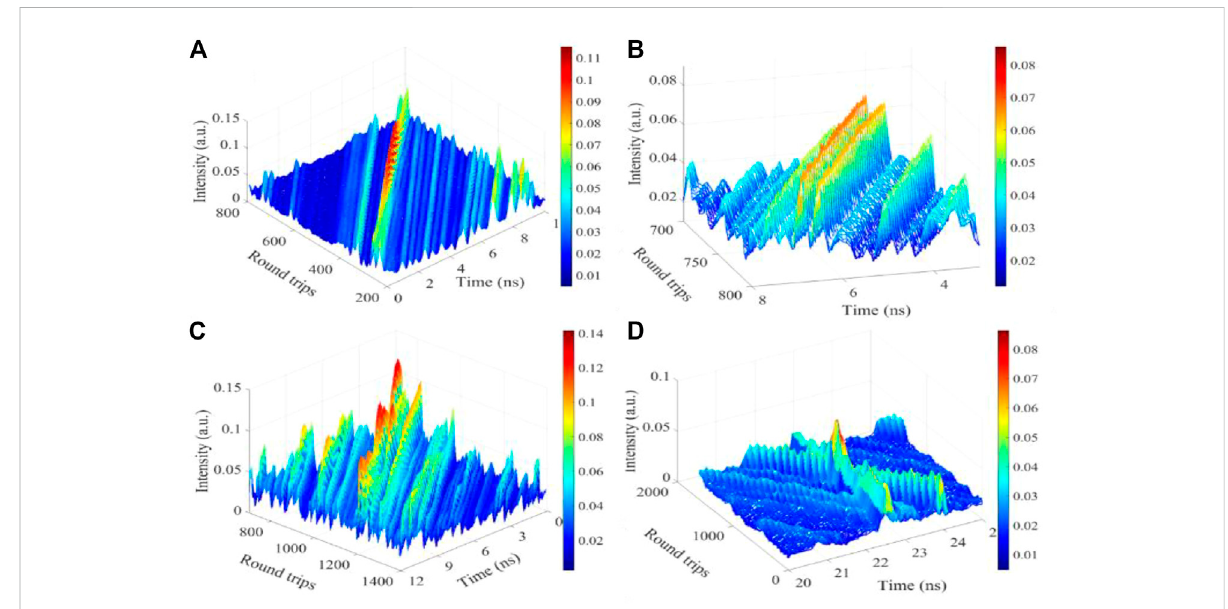
FIGURE 5 FORW, (A) lonely, (B) twins;, (C) three sisters, and (D) cross RW patterns.